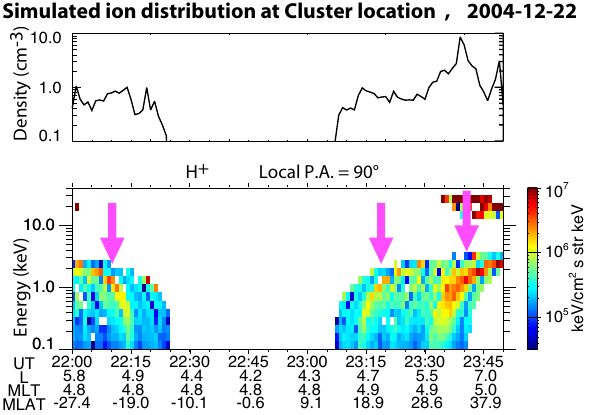
Fig. 5. Number density (upper panel) and energy-time energy flux spectrogram (lower panel) of simulated H + using drift model start- ing from an estimated source distribution, which is obtained, by the power-law fitting of the distribution in Fig. 4, and by assuming uni- form over the entire MLT in the source region (all nightside). The wedge-like structure is marked by vertical arrows. The model is described in Sect. 3 and Ebihara et al. (2004,